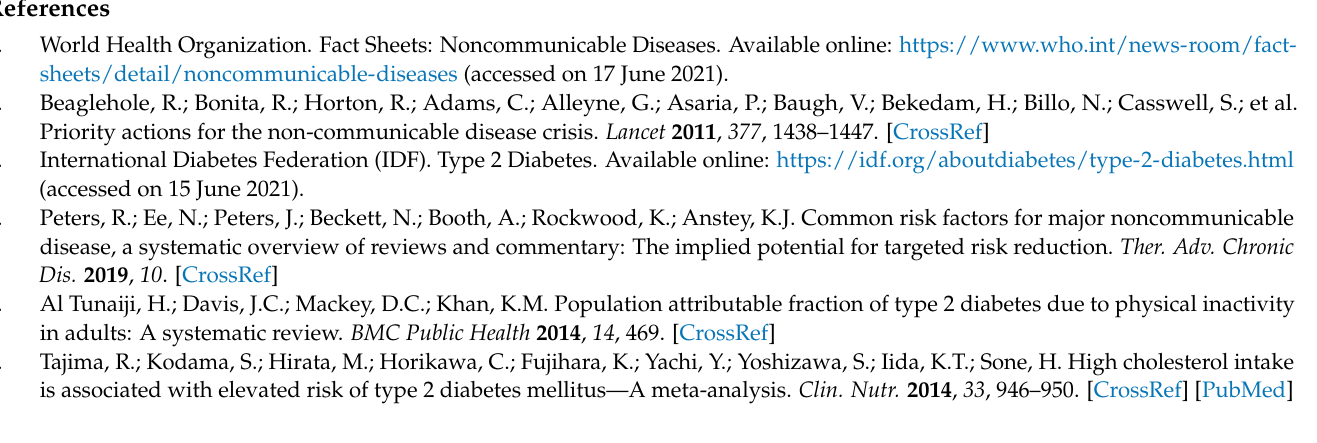
Table S3: Distribution of demographic, socioeconomic and lifestyle characteristics of the study population in